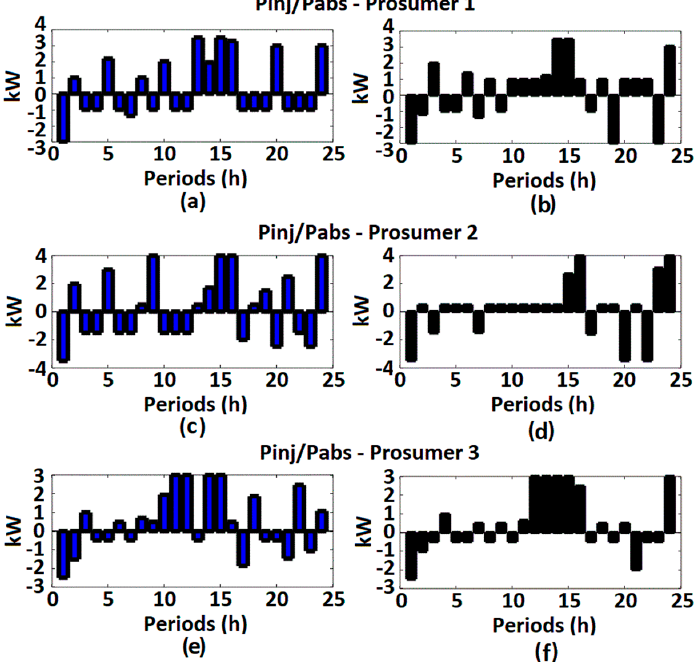
Figure 7. Injection P inj and absorption P abs powers related to the SB of the prosumer 1 (( a ) Case 1, Figure 7. Injection 𝑃 (cid:3048),(cid:3047)(cid:3036)(cid:3041)(cid:3037) and absorption 𝑃 (cid:3048),(cid:3047)(cid:3028)(cid:3029)(cid:3046) powers related to the SB of the prosumer 1 (( a ) u , t u , t Figure 7. Injection 𝑃 (cid:3048),(cid:3047)(cid:3036)(cid:3041)(cid:3037) and absorption 𝑃 (cid:3048),(cid:3047)(cid:3028)(cid:3029)(cid:3046) powers related to the SB of the prosumer 1 (( a ) Case 1, and ( b ) Case 2); prosumer 2 (( c ) Case 1, and ( d ) Case 2); and prosumer 3 (( e ) Case 1, and ( f ) and ( b ) Case 2); prosumer 2 (( c ) Case 1, and ( d ) Case 2); and prosumer 3 (( e ) Case 1, and ( f ) Case Case 1, and ( b ) Case 2); prosumer 2 (( c ) Case 1, and ( d ) Case 2); and prosumer 3 (( e ) Case 1, and ( f ) Case 2). Case 2).